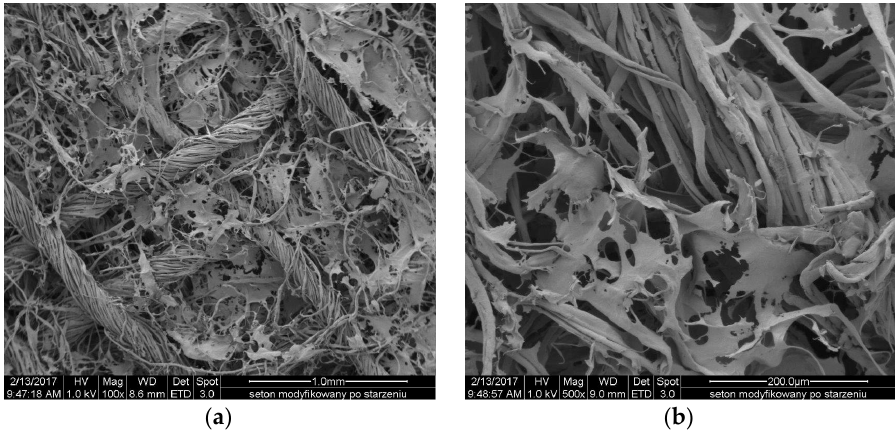
Figure 12. Scanning Electron Microscope Study (SEM) microphotographs of impregnated gauze after accelerated ageing: ( a ) at magnification 100×; and ( b ) at magnification 500×. After the accelerated ageing process, no significant changes in the structure and topography of the impregnated gauze were observed. The structure of the impregnation was similar in view to those that were observed in the impregnated gauze before accelerated ageing.